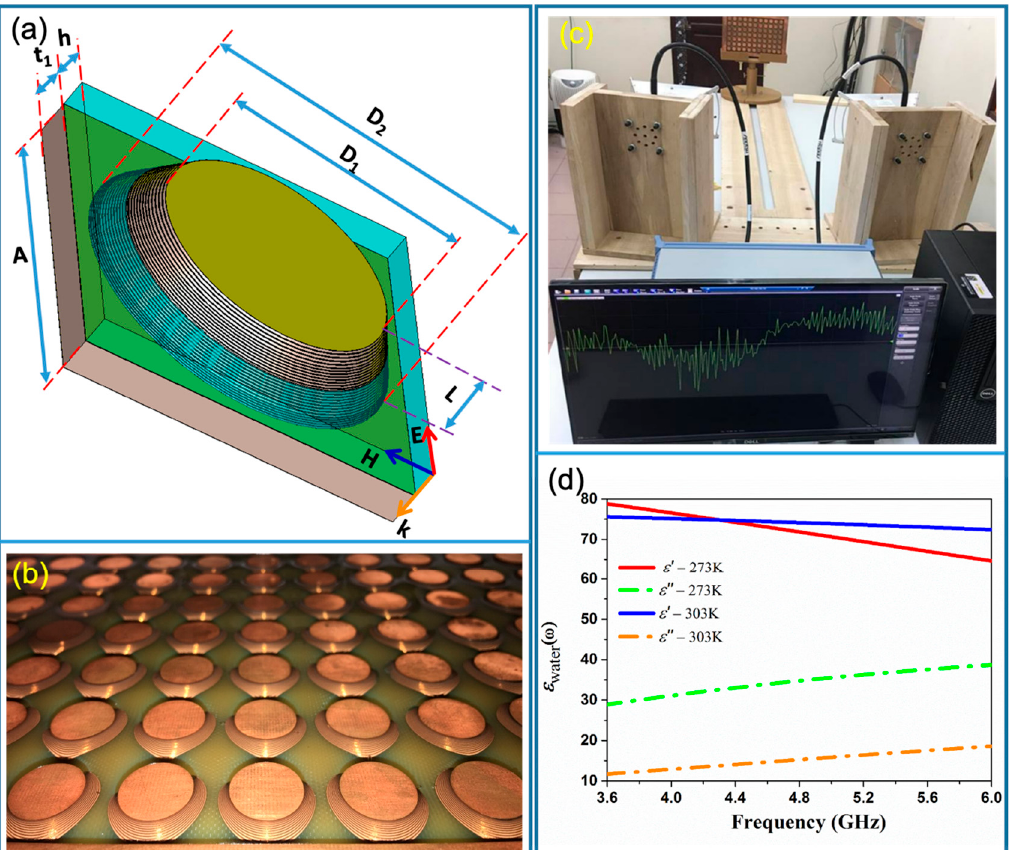
Figure 1. ( a ) Three-dimensional schematic of the water-hybrid metamaterial absorbers (MA); ( b ) fabricated truncated cone-type resonator (TCR)-MA hybridized with water; ( c ) measurement setup for the proposed TCR-MA by using ZNB20 vector network analyzer; ( d ) real part 𝜀 ’ and imaginary part 𝜀 ” of the complex permittivity for water at 273 K and 303 K.